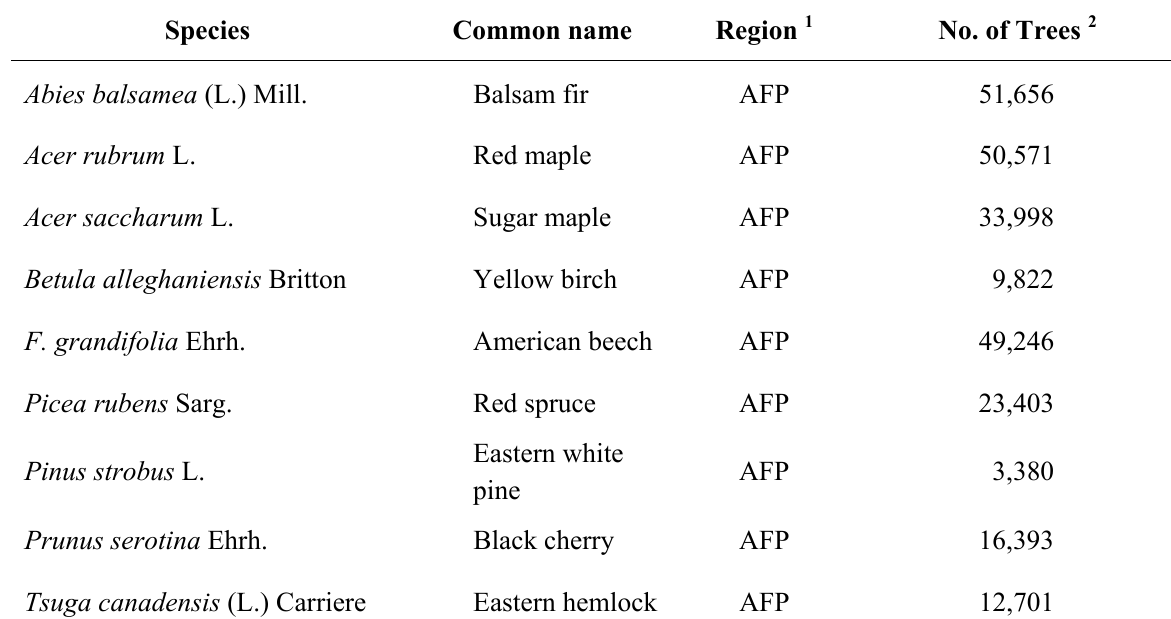
Table 1. Scientific and common names, sampling site locations, number of trees, total area sampled, and mean plot size for each of the 22 species populations utilized for baseline mortality